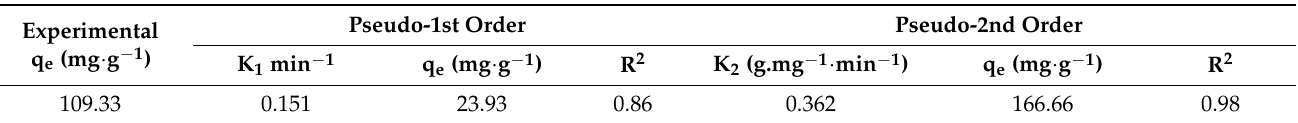
Table 1. Kinetics parameters, for adsorption of Cr(VI) on MNPs/rGO/PMMA composite; pH 2; contact time, 30 min; adsorbent amount, 150 mg. Experimental